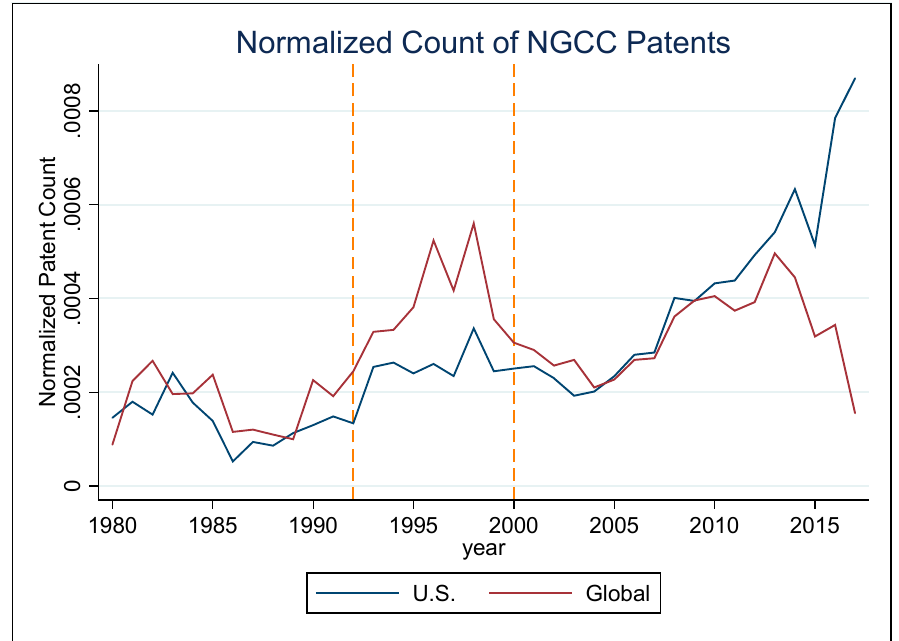
Figure 2. Normalized count of granted NGCC patents for the U.S. and all countries (global) before, during (1992–2000), and after the U.S. Department of Energy Advanced Turbine System (DOE-ATS) program using data from the Worldwide Patent Statistical Database (PATSTAT).